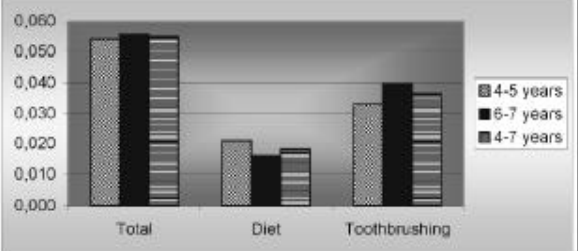
FIGURE 1- Daily fluoride intake (mg / kg body weight) from diet, dentifrice and